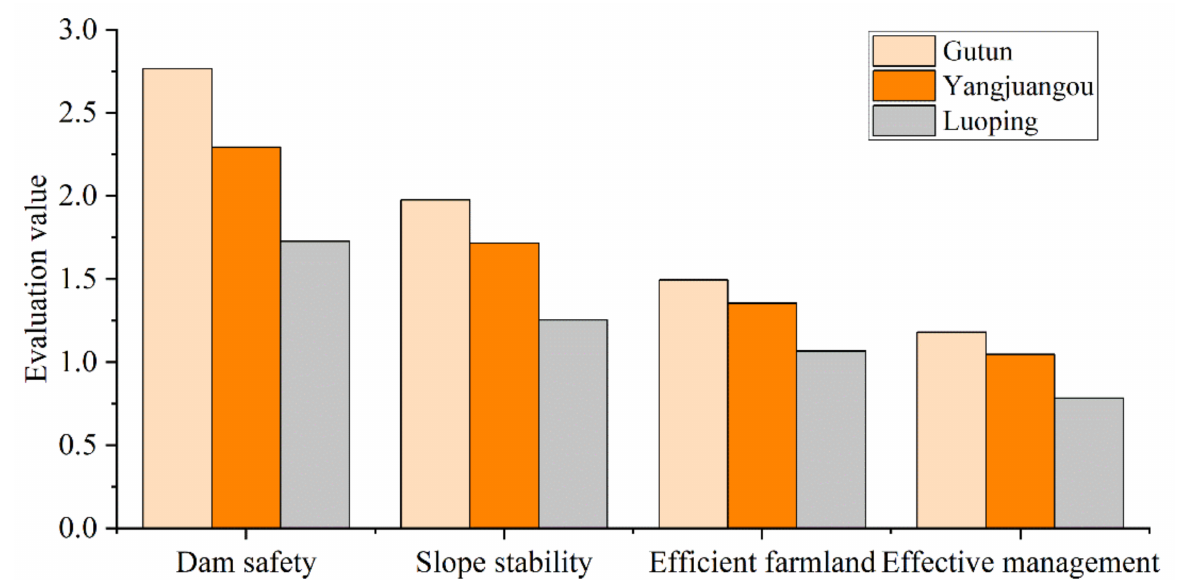
Figure 3. Evaluation value of the first-level indexs of ecological safety effects in different gully land consolidation project (GLCP)